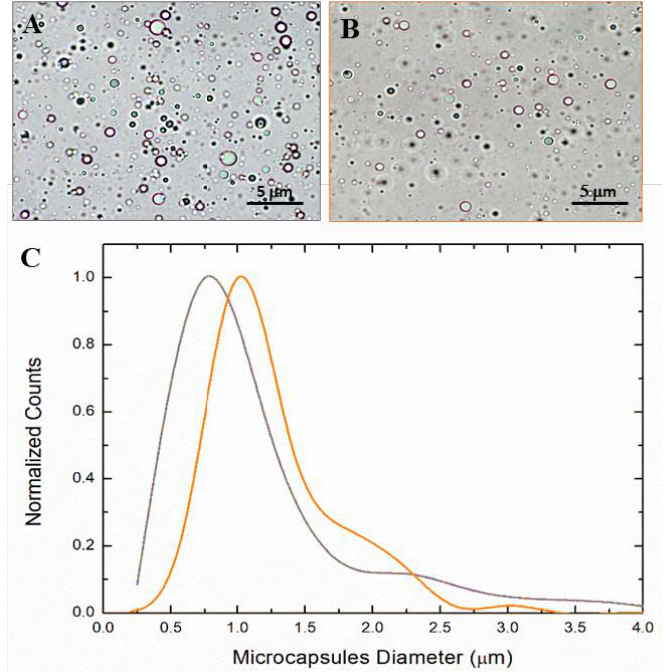
Figure 4. Optical microscopy images of oyster glycogen microcapsules (OG mc ) prepared using 10 mg/mL with ( A ) 50 μL Soybean Oil (SO) and ( B ) 30 μL of SO. ( C ) Comparison of the normalized size distribution of OG mc obtained by embedding 30 μL (orange) and 50 μL (grey) of SO.